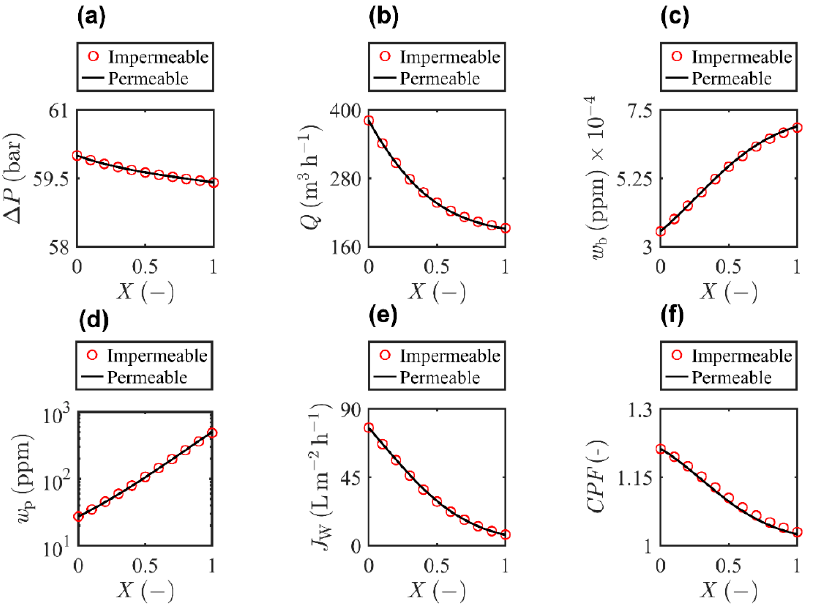
Figure 9. The simulated results at the system level using the impermeable and permeable wall models with the feed salinity ( w b, 0 = 35,000 ppm), water recovery ( R r, 0 = 50%), pump efficiency (0.85), energy recovery device efficiency (0.95) and water permeability ( L p = 3 L m − 2 h − 1 bar − 1 ). ( a ) Transmembrane pressure, ∆ P (bar), ( b ) Flow rate, Q (m 3 h − 1 ), ( c ) Brine salinity, w b (ppm), ( d ) Permeate salinity, w p (ppm), ( e ) Permeation flux of water, J W (L m − 2 h − 1 ), ( f ) CP factor, CPF ( − ) along the dimensionless length ( X ).